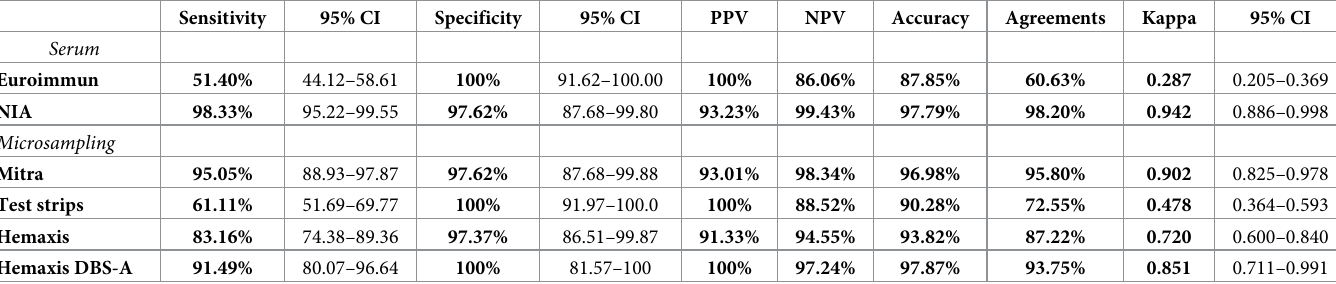
Table 1. Performance characteristics of microfluidic nano-immunoassay (NIA) index test.